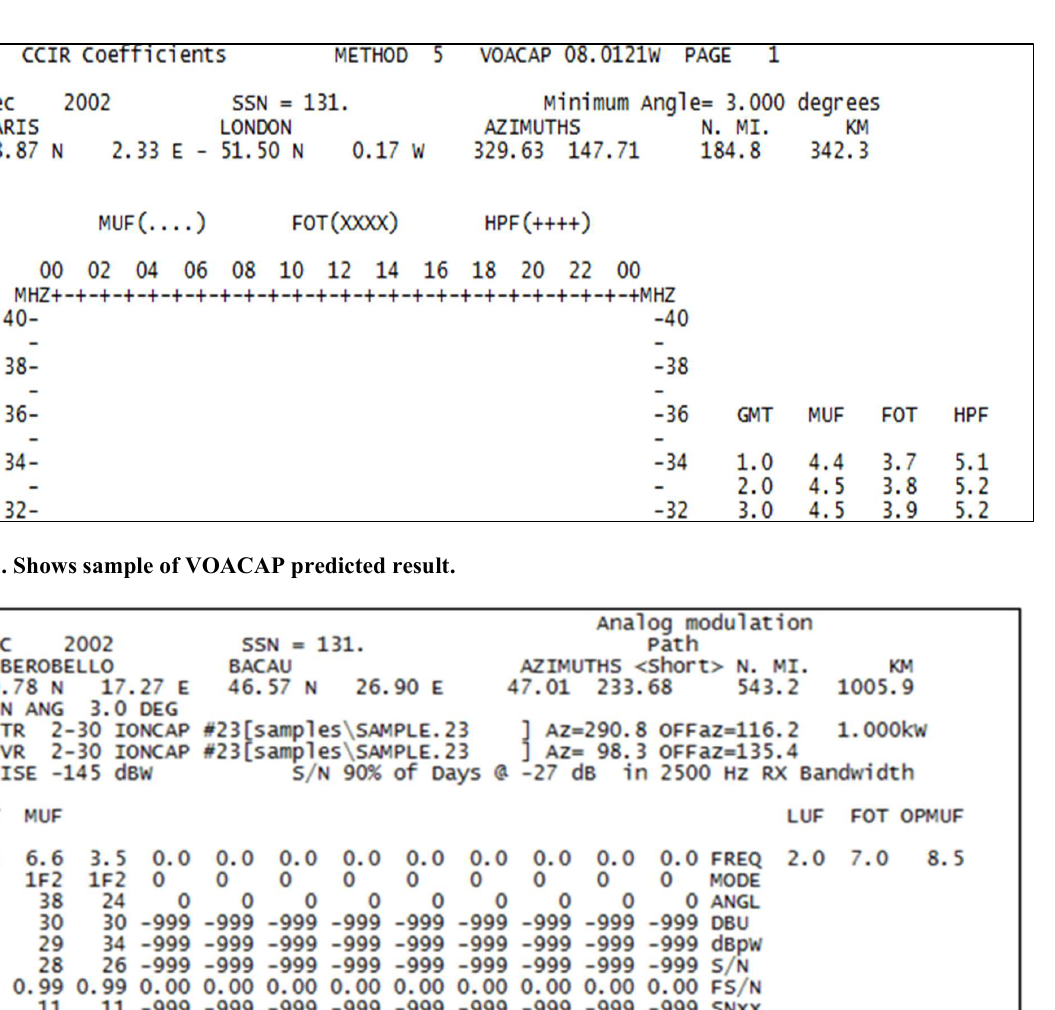
Fig. 2. Shows REC533 program interface.